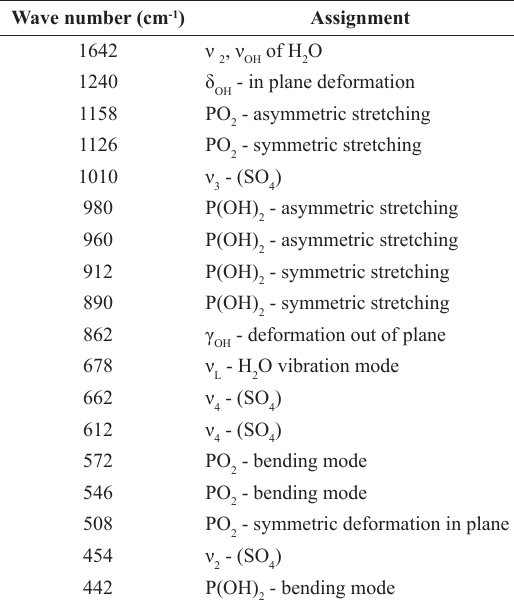
Table 2. IR band assignment for gypsum and monocalcium